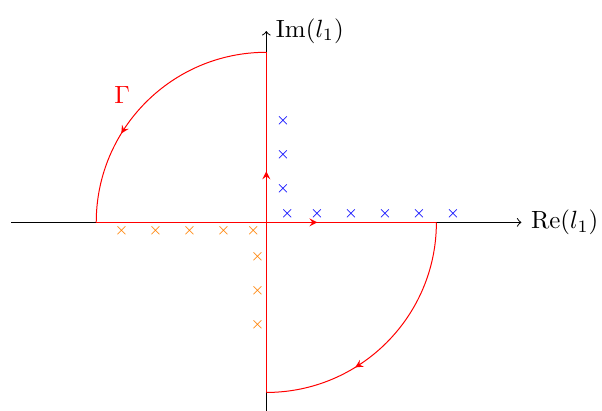
(in blue) and l ( − ) (in orange) in the case u = 0 for different real values of Figure 9 . Solutions l (+) 1 1 l 0 . The red contour Γ does not enclose poles of the